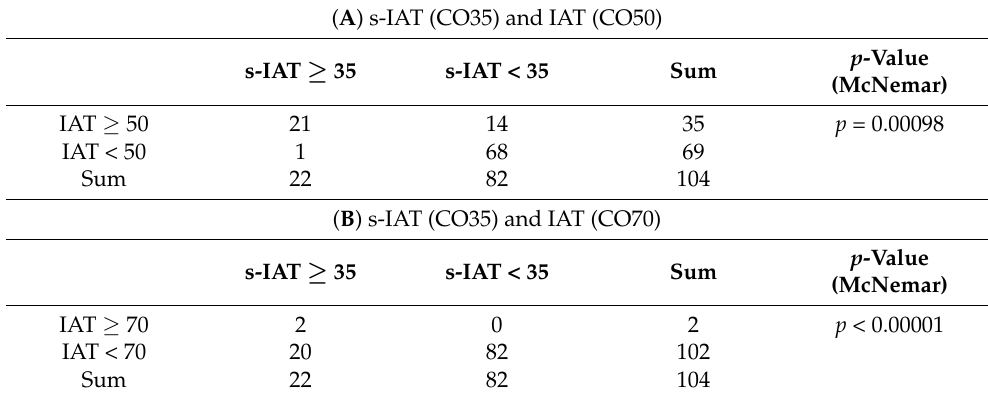
Table 4. Cross-tabulation table of the s-IAT and IAT at different cut-off